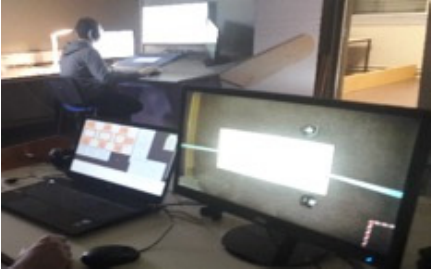
Figure 6. Experimentation supervision workplace (Organization